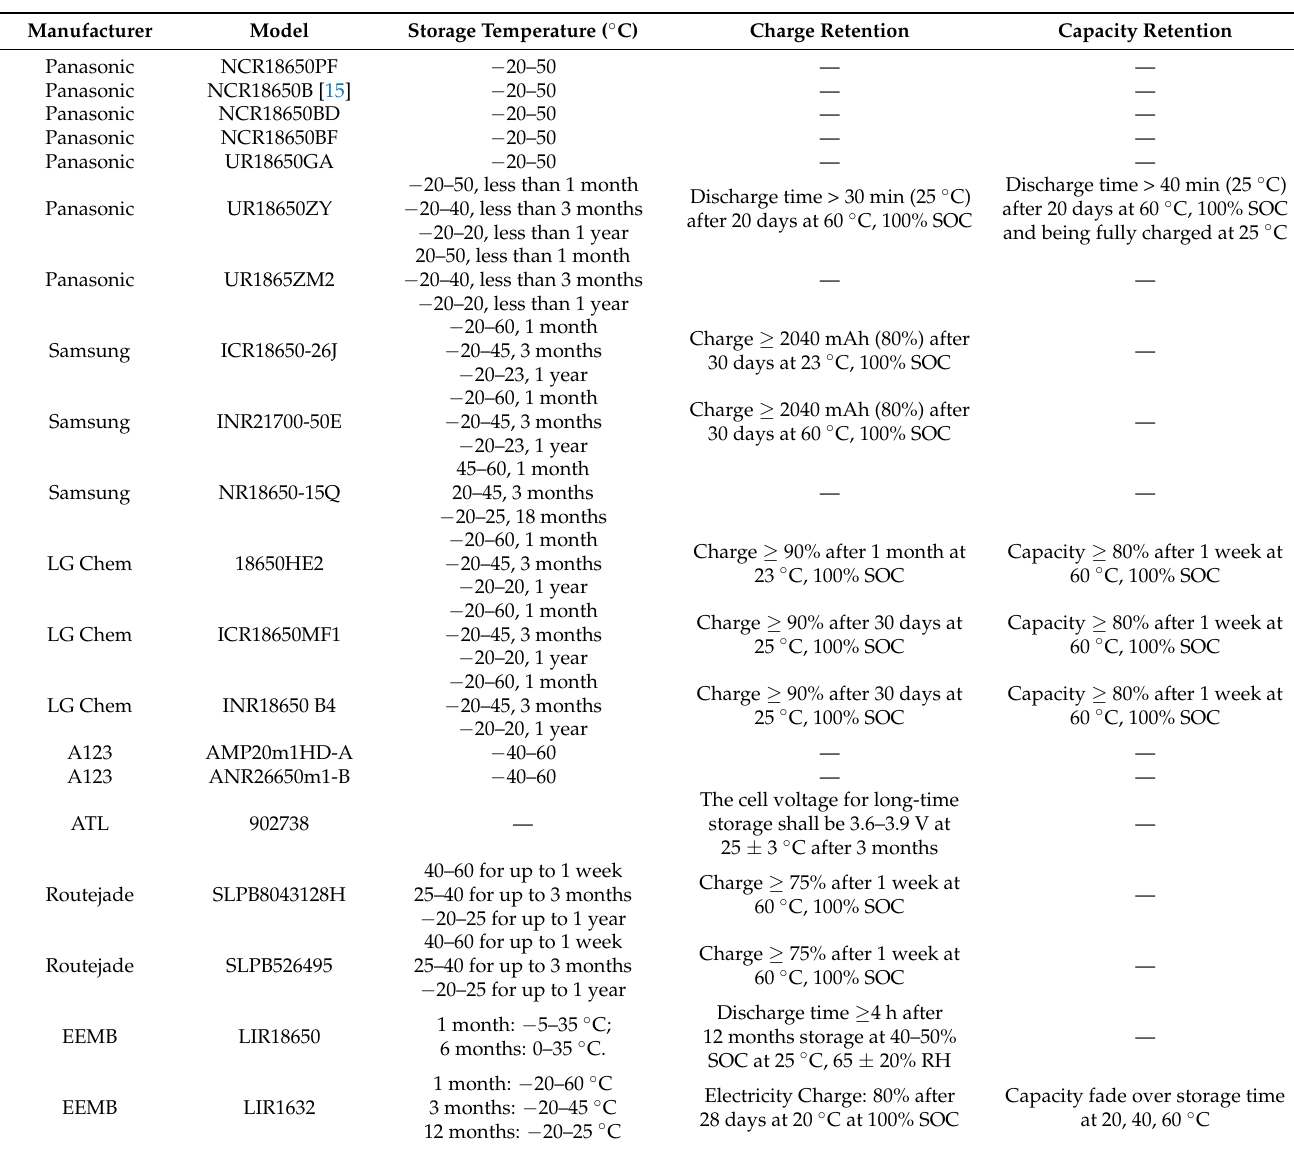
Table 8. Storage life